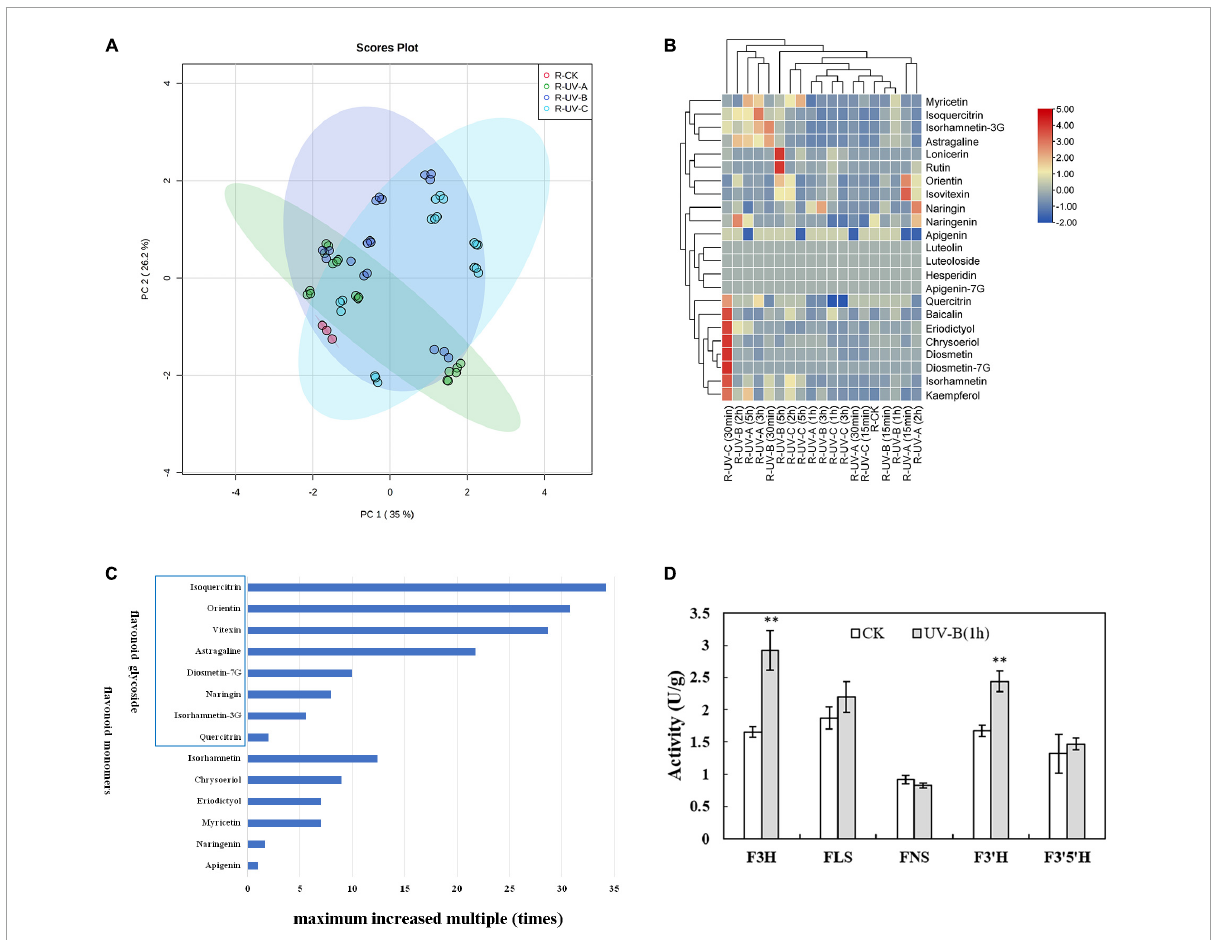
FIGURE4 Flavonoid metabolites in root tubers of Tetrastigma hemsleyanum with UV treatments. (A) PCA score plot of metabolites in root tubers. (B) Heatmap of flavonoid metabolites in root tubers. (C) The maximum increased multiple of flavonoid monomers with different structural characteristics in root tubers. (D) Activities of flavanone 3-hydroxylase (F3H), flavonol synthase (FLS), flavone synthase (FNS), flavonoid-3 (cid:48) -hydroxylase (F3 (cid:48) H), flavonoid-3 (cid:48) ,5 (cid:48) -hydroxylase (F3 (cid:48) 5 (cid:48) H) enzyme with UV-B 1 h treatment in root tubers. * P < 0.05, ** P <